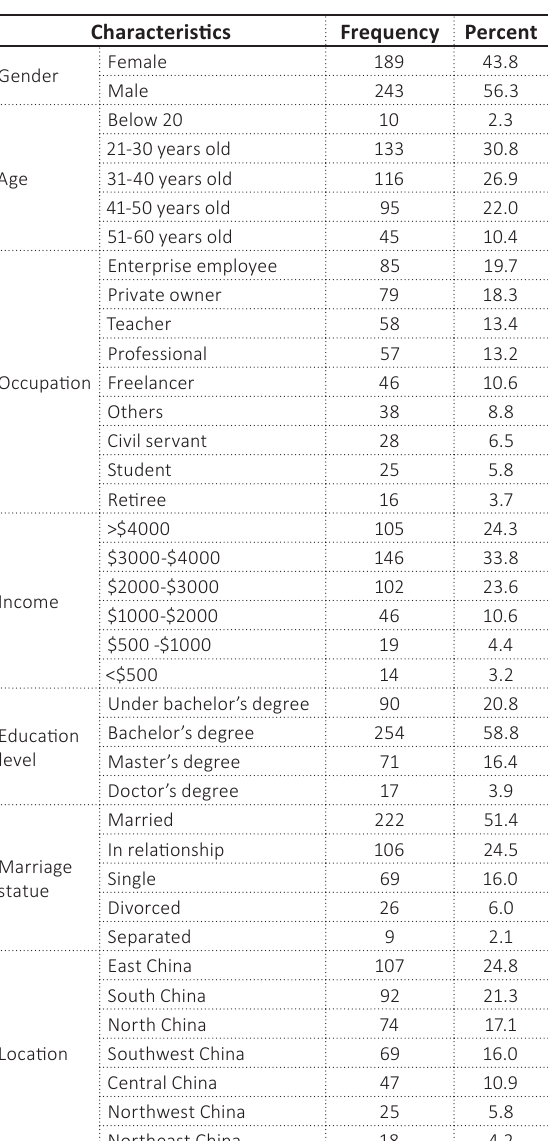
Table 1. Demographics of the sample